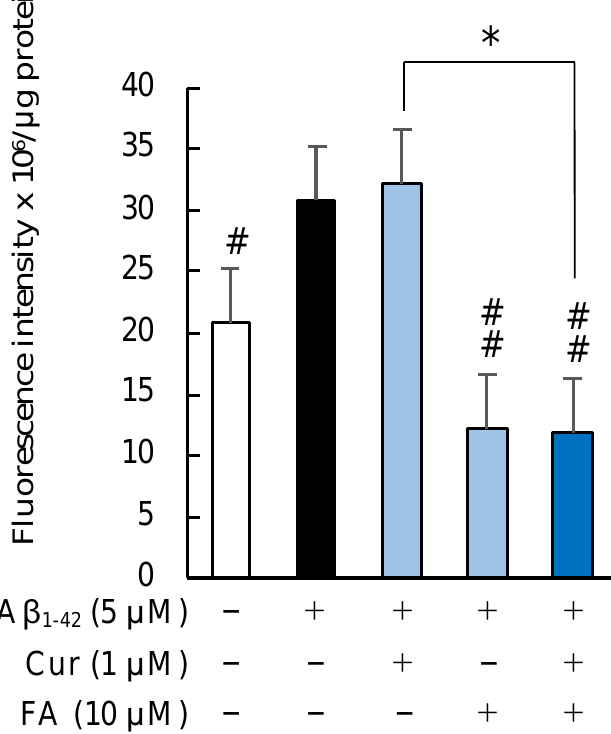
Figure 8. Effect of Cur, FA, or a combination of both on membrane phospholipid peroxidation level in Aβ -stimulated SH-SY5Y cells. The levels of membrane phospholipid peroxidation in Aβ - 1 – 42 1 – 42 stimulated SH-SY5Y cells was evaluated using DPPP. The levels of membrane phospholipid perox- idation in SH-SY5Y cells exposed to 5 µM Aβ and treated with Aβ + 1 µM Cur, Aβ + 10 µM 1 – 42 1 – 42 1 – 42 FA or A β + Cur + FA. In the absence of 5 μM Aβ , the membrane phospholipid peroxidation 1 – 42 1 – 42 levels of control, 1 μM Cur, 10 μM FA and Cur + FA -treated cells were 20.58 ± 2.41, 21.97 ± 2.18, 18.31 ± 1.54 and 17.77 ± 1.93 fluorescence intensity × 10 6 /μg protein ( no significant difference, n = 6, Tukey). +: inclusion of 5 μ M A β , 1 μ M Cur, 10 μ M FA, respectively, − : non-inclusion. The p - 1 ̶̶ 42